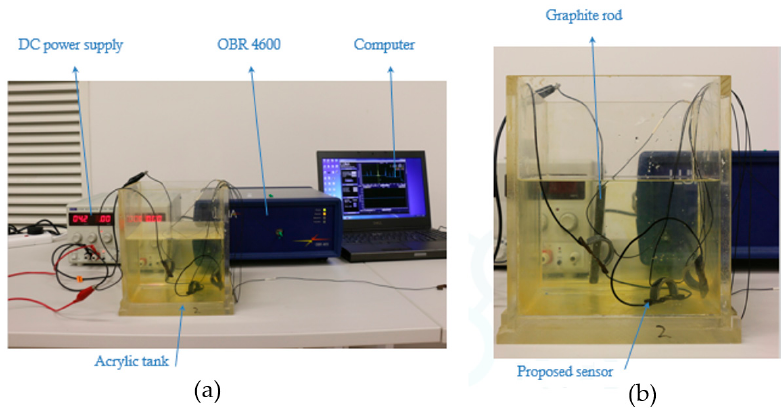
Figure 13. ( a ) Experimental test set-up. ( b ) and details of the apparatus inside acrylic tank.